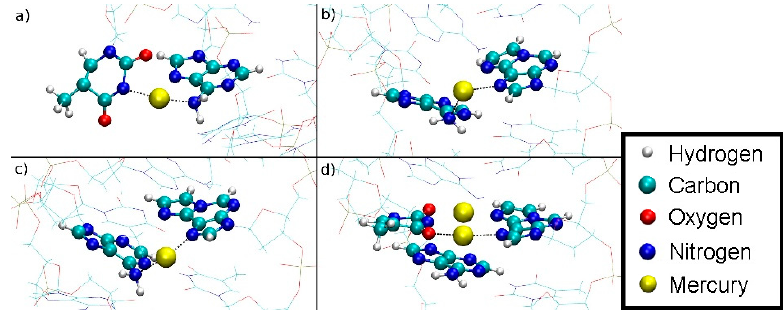
Figure 17. Simulated path of the Hg1 into the DNA duplex for structure 1 as derived from assuming microscopic reversibility of the dissociation of structure 1 . The sp 3 -like hybridized amino group of A 8 can clearly be discerned based on the orientation of its protons. ( a ) D DNA = 5.8 Å , Hg(II) outside the DNA duplex in water, attached to the NH 2 group of A 8 and a dangling T 7. ( b ) D DNA = 4.5 Å, the NH 2 group is rotated about the C6–N6 bond and the Hg(II) is being attached to ε A 20. ( c ) D DNA = 3.6 Å, further rotation of the NH 2 group. ( d ) D DNA = 3.1 Å, inclusion of Hg1 into the metal-mediated base pair with Hg2 also shown. The NH 2 group is now sp 2